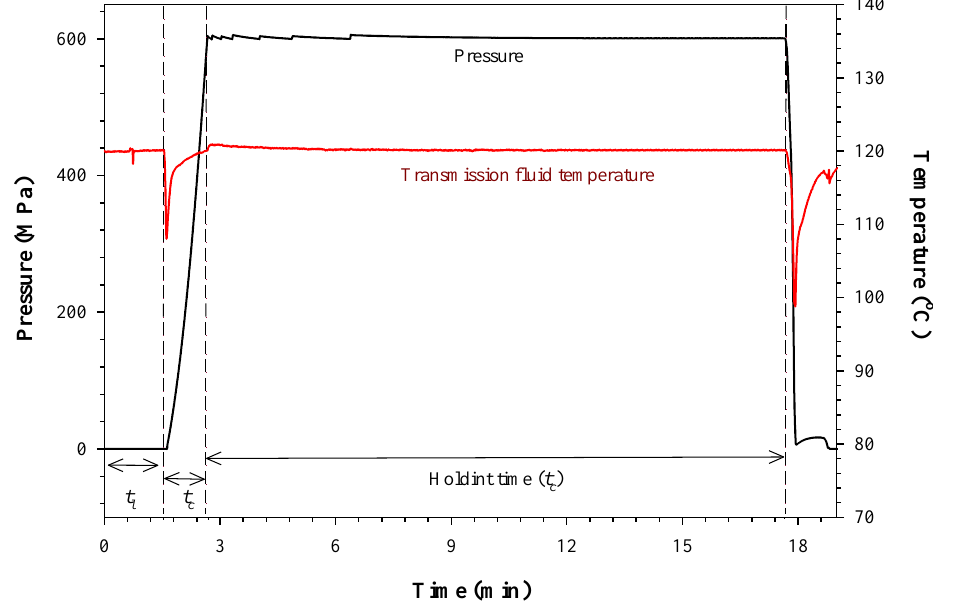
Figure 1. Typical pressure, temperature and time history during pressure-assisted thermal processing of conjugated linoleic acid (CLA)-enriched milk treated at 600 MPa/120 °C ( t l , loading time; t c , compression time; t h , holding